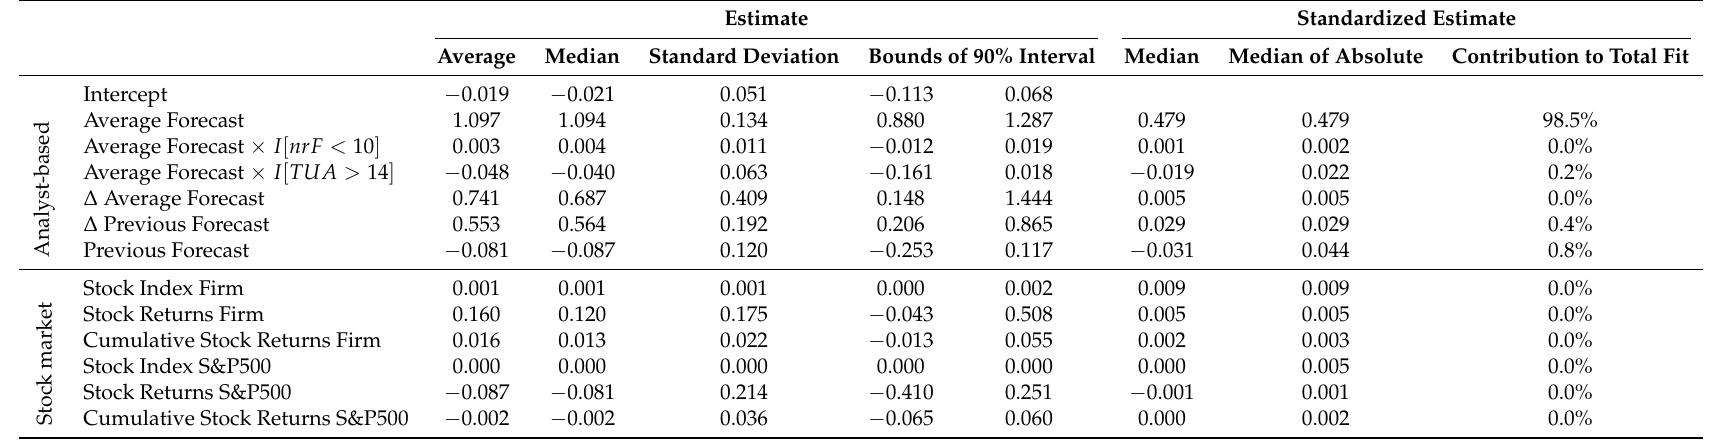
Table 5. A summary of estimation results of forecasting earnings forecasts, after using the correction method to account for small-sample error. Results are for the estimation sample, which amounts to 316 firms, 18,338 forecasters and 146,319 forecasts (on average slightly more than 463 forecasts per firm). As variable to be explained, we used the earnings forecasts by the analysts. As explanatory variables, we included the variables mentioned in Table 2. The regression was run individually for each firm, and the table shows statistics which summarize these results. The first five columns contain summary results on the regular parameter estimates (average, median, standard deviation and bounds of a 90% interval). The last three columns show summarized results for the standardized estimate, which is included to compare contributions to fit. The standardized estimate is defined as the estimate that would have been obtained had the regressor been standardized beforehand (which is a transformation to having an average of zero and a standard deviation of one). The correction method is based on the assumption of an underlying distribution out of which each variable (for the different firms) is drawn. This provides additional information on the firm-specific estimate especially in the case when the firm has only a few